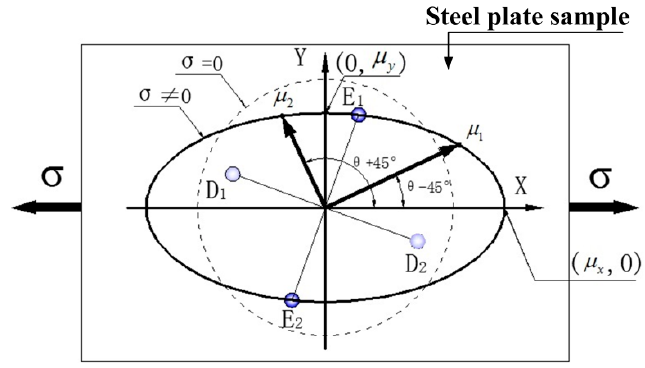
Figure 3. Elliptical distribution diagram of permeability in a steel plate under the stress state.